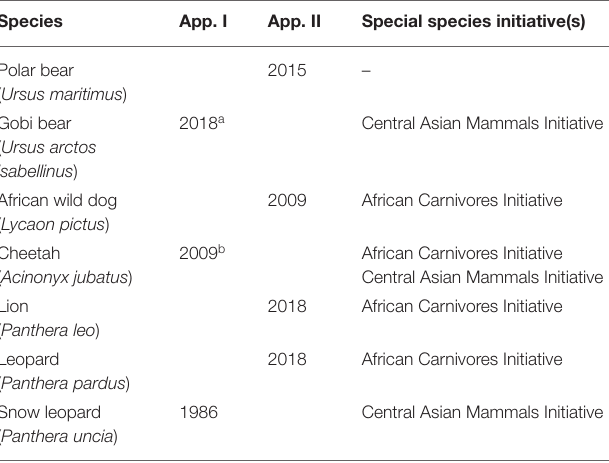
TABLE 1 | Large carnivore (sub)species covered by CMS appendices and SSIs, with years in which their listings entered into effect. Species App.